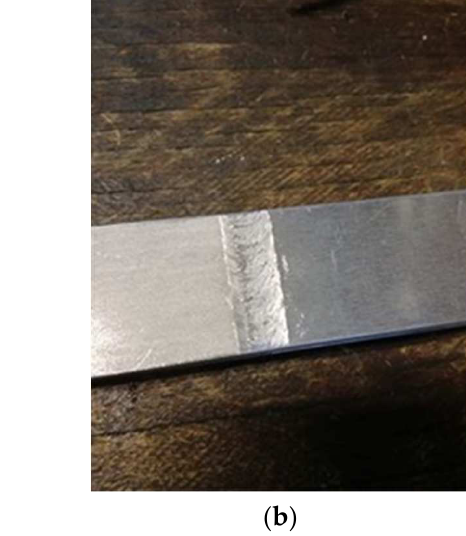
Figure 7. ( a , b ) Pictures of specimens prepared for tensile testing.